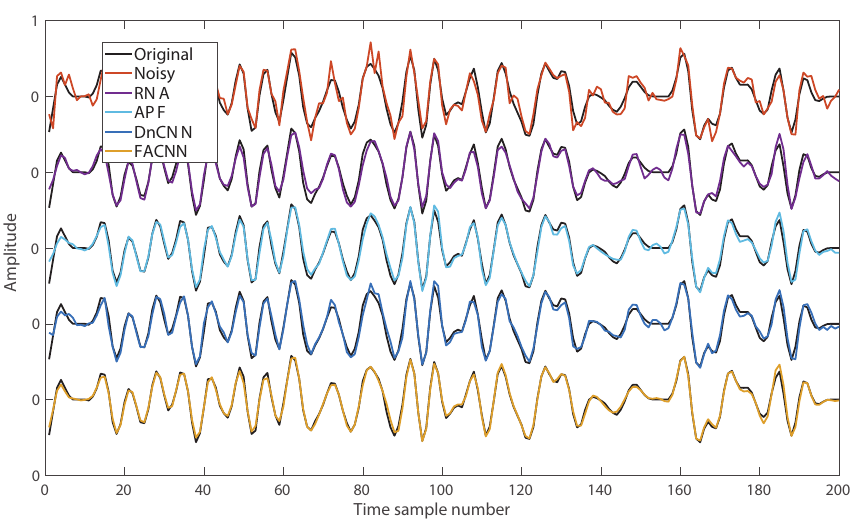
Figure 5. The 50th trace comparison of different methods.